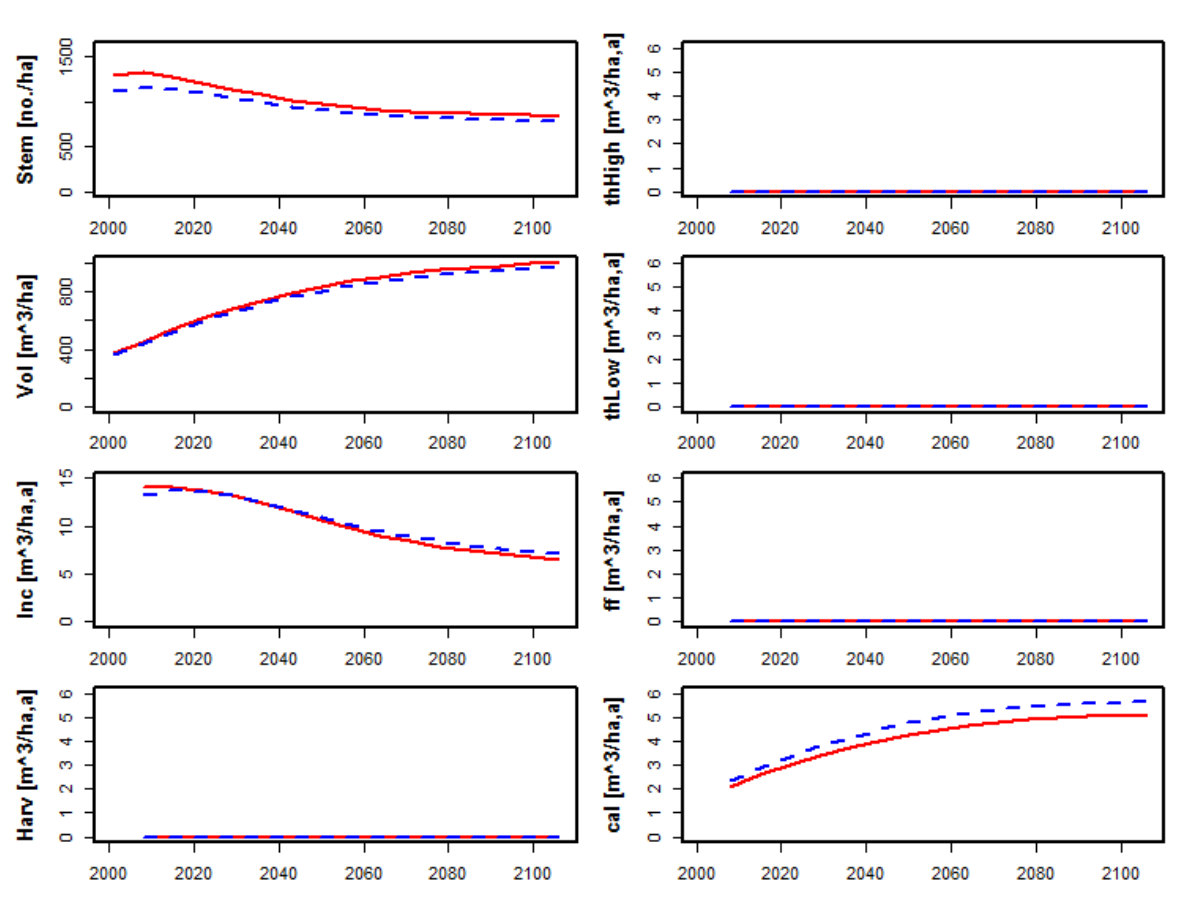
Figure 1. Development of the Norway spruce forest on elevation class 1 (red line) and 2 (blue dash line) when no harvests are simulated. The calamity coefficients are 0.42 (elevation 1) and 0.5 (elevation